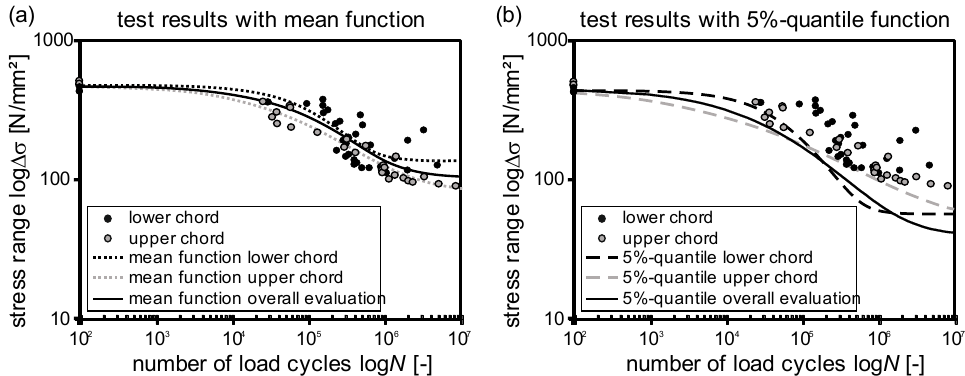
Figure 9. Fatigue test results of lower and upper chords with mean functions ( a ) and 5% quantile functions ( b ) [43].